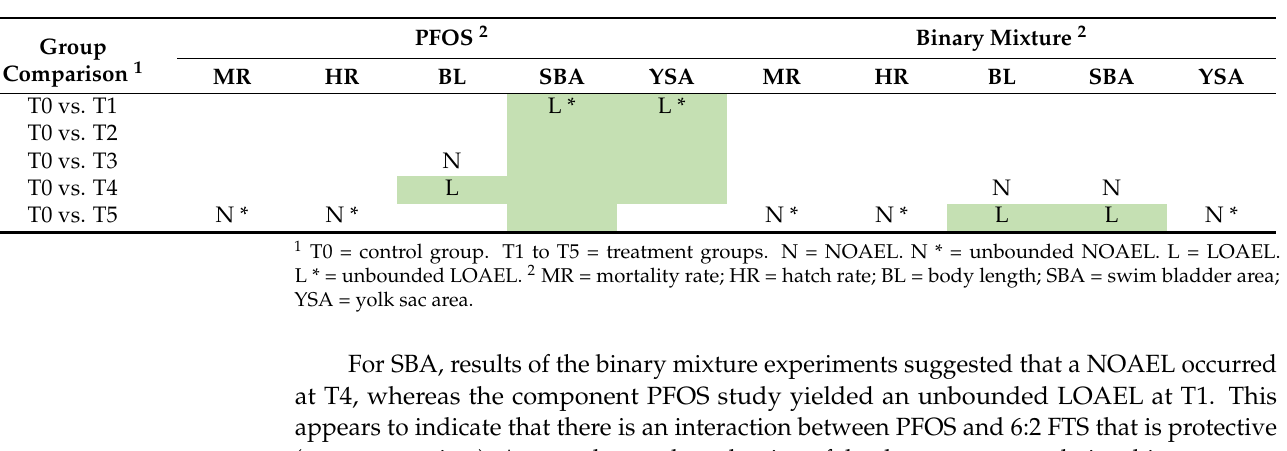
Table 2. ANOVA results (shaded squares are statistically significant, p <